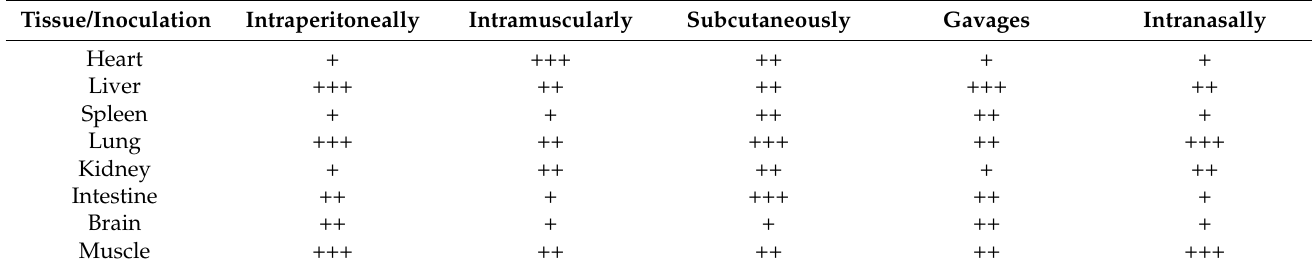
Table 2. CEV-JL14 antigen detected in tissues in mice infected with different